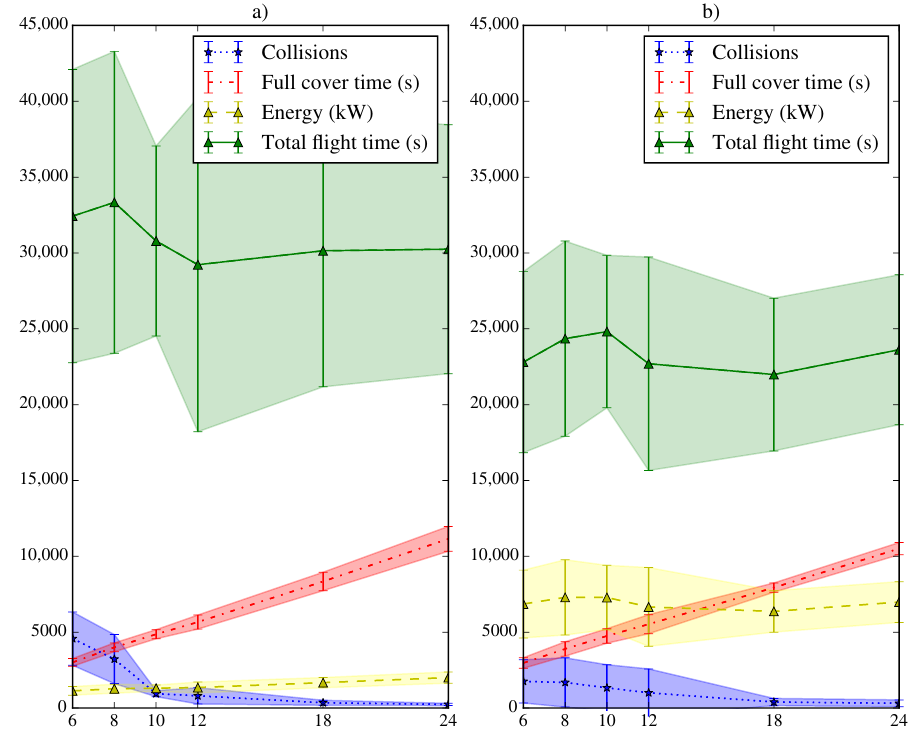
Figure 14. Results of the SLABE ( a ) and SEPHE ( b ) behavior simulations, equivalent to those presented in Figure 13, with an energy model for SLABE agents with lower consumption, where active agents consume 12 W and repeater agents consume 0.5